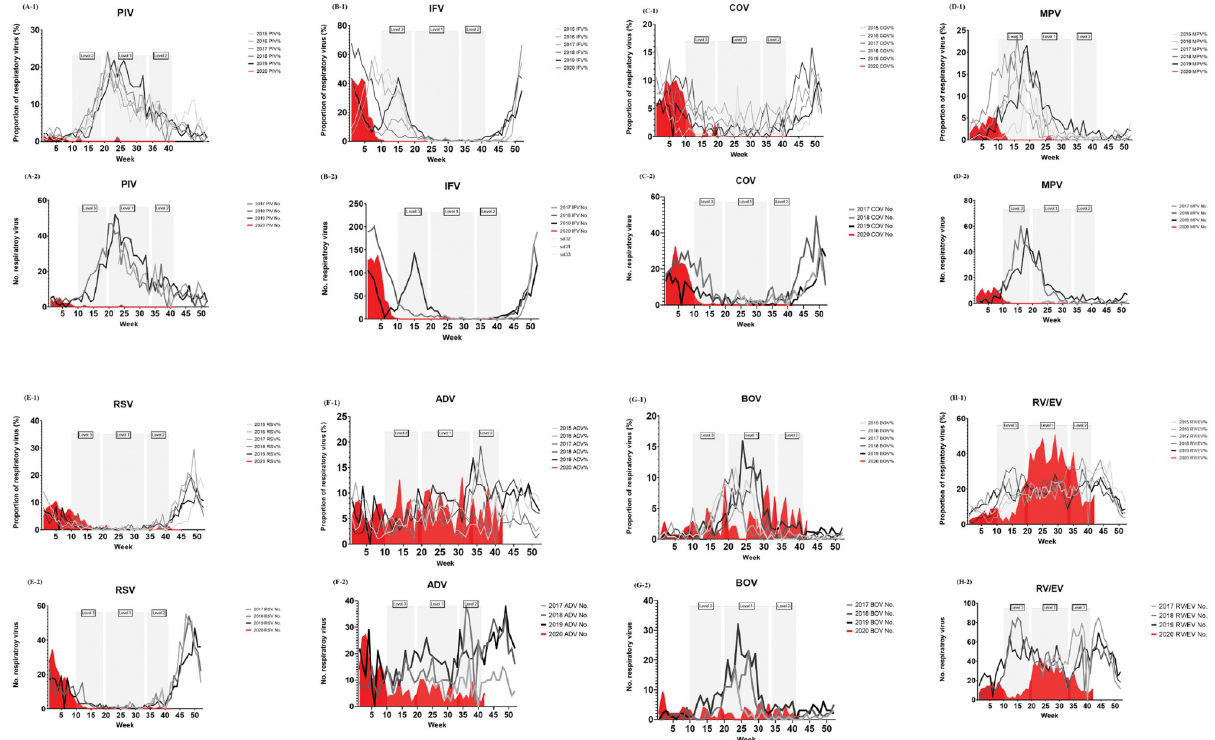
Fig 3. Weekly number and positive rates of respiratory viruses in South Korea between the 1st week of 2015 and the 42nd week of 2020. A-1. Proportion of Parainfluenza virus (PIV); A-2. Number of PIV; B-1. Proportion of Influenza virus (IFV); B-2. Number of IFV; C-1. Proportion of Human coronavirus (COV); C-2. Number of COV; D-1. Proportion of Human metapneumovirus (MPV); D-2. Number of MPV; E-1. Proportion of Respiratory syncytial virus (RSV); E-2. Number of RSV; F-1. Proportion of Adenovirus (ADV); F-2. Number of ADV; G-1. Proportion of Human bocavirus (BOV); G-2. Number of BOV; H-1. Proportion of Rhinovirus/enterovirus (RV/EV); H-2. Number of RV/EV. Each of gray squares represents the periods of level 3, level 1, and level 2 social